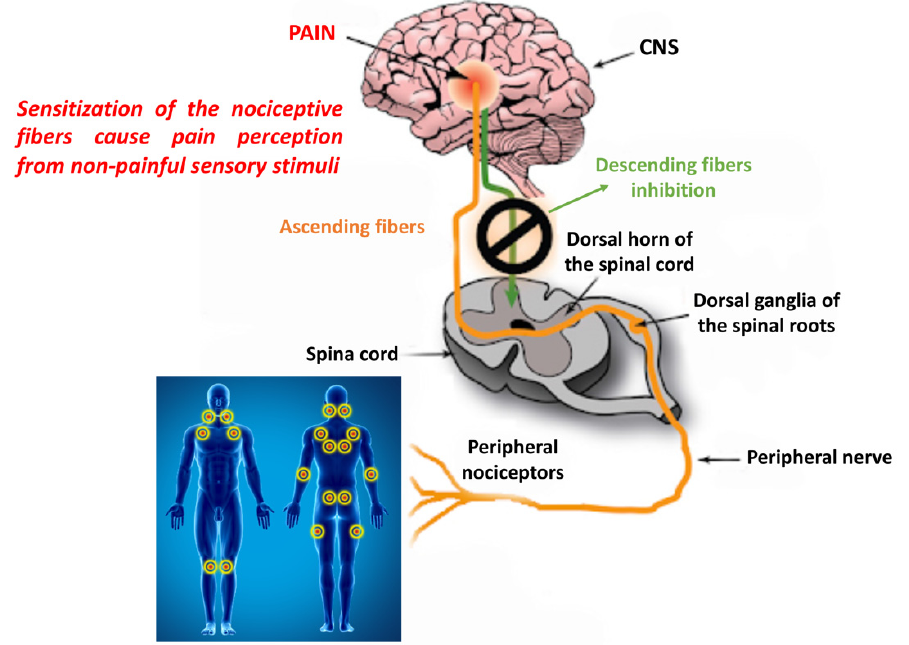
Figure 2. Ascending and descending pathways that influence pain sensitivity.